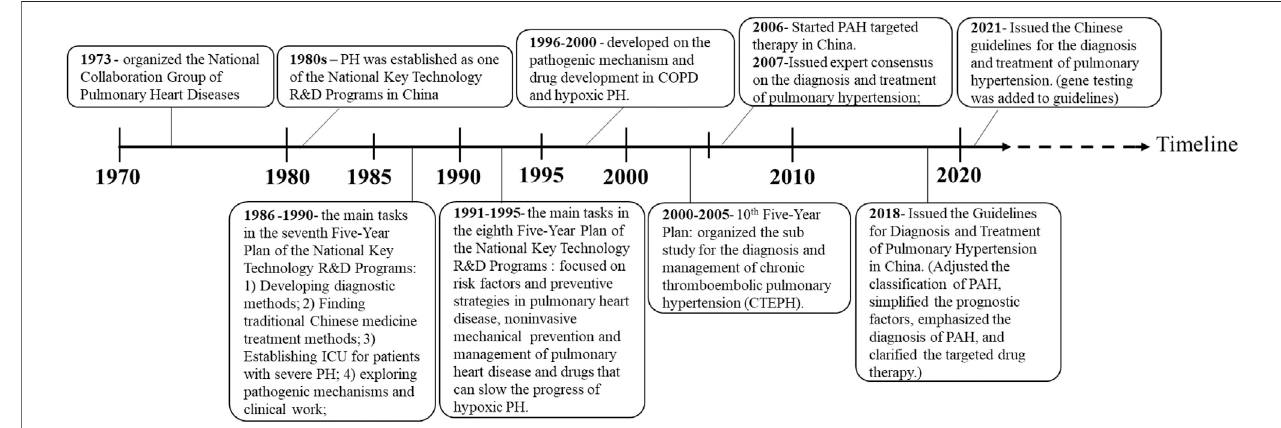
FIGURE 1 | Brief history of PAH research in